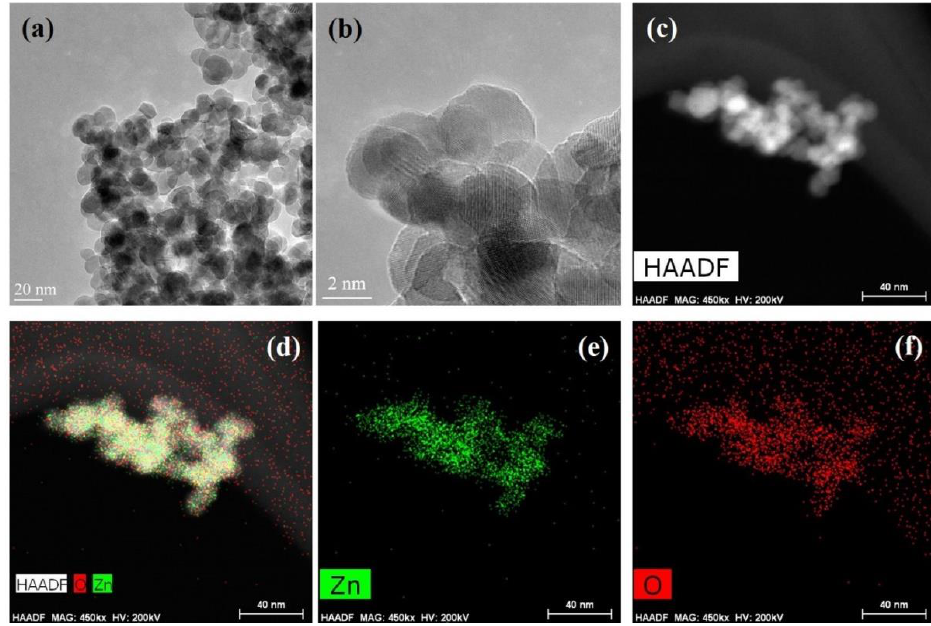
Figure 5. TEM images and EDS element mapping of zinc oxide spherical nanoparticles: ( a – b ) TEM image of ZnO SNPs and ( c – f ) the elemental mapping images of ZnO SNPs, where Zn and O elements are displayed, respectively, as green and red colors.